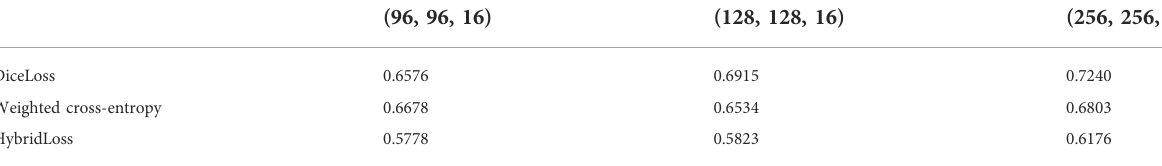
TABLE 2 DSC values for different patch sizes and loss functions of the training set.